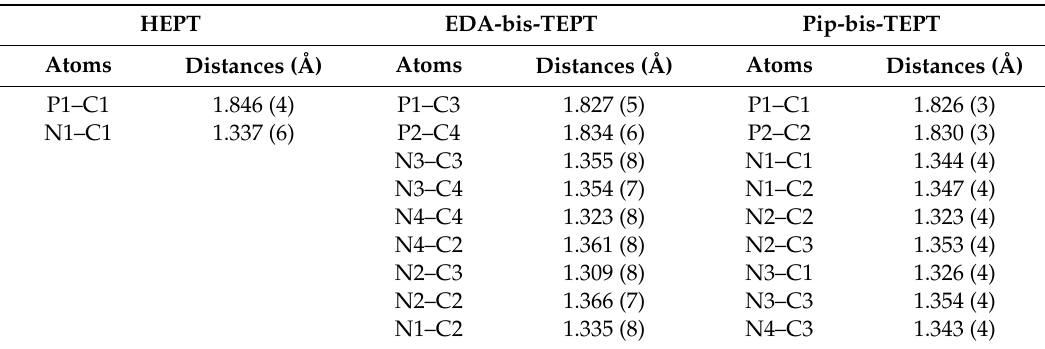
Table 1. Selected bond distances (Å) for the synthesized compounds 2,4,6-trisdiethoxyphosphinyl-1,3,5 -triazine (HEPT); N , N (cid:48) -Bis[4,6-bis(diethylphosphono)-1,3,5-Triazin-yl]-1,2-diaminoethane (EDA-bis-TEPT); N , N (cid:48) -Bis[4,6-bis(diethylphosphono)-1,3,5-Triazin-yl]-piperazine (Pip-bis-TEPT). HEPT EDA-bis-TEPT Pip-bis-TEPT Atoms Distances (Å) Atoms Distances (Å) Atoms Distances (Å) P1–C1 1.846 (4) P1–C3 1.827